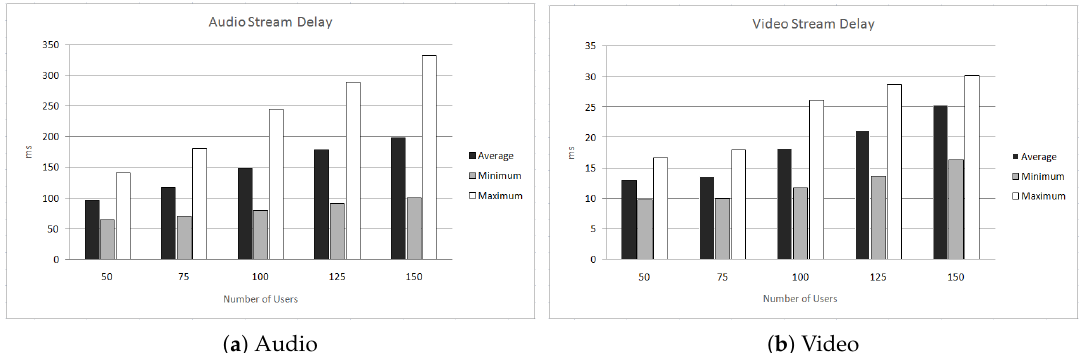
Figure 9. Audio and video stream delay (average, minimum, and maximum) varying users